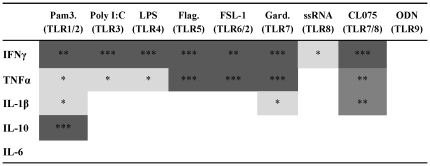
TLR agonists induce greater cytokine production in Gambian newborns
at 1 month compared to at birth.100 µl whole blood was cultured overnight with each of the TLR
agonists and cytokine production (pg/mL) in supernatants was measured as
described in the Materials and
Methods. Comparisons between cytokine levels at birth and 1
month of age were calculated using a non-parametric Mann Whitney test.
*(light grey square) p = 0.05 – 0.019,
**(medium grey square) p = 0.01 –
0.001, ***(dark grey square) p<0.001. Pam3.
 = Pam3CysSerLys4, Gard.
 = Gardiquimod.